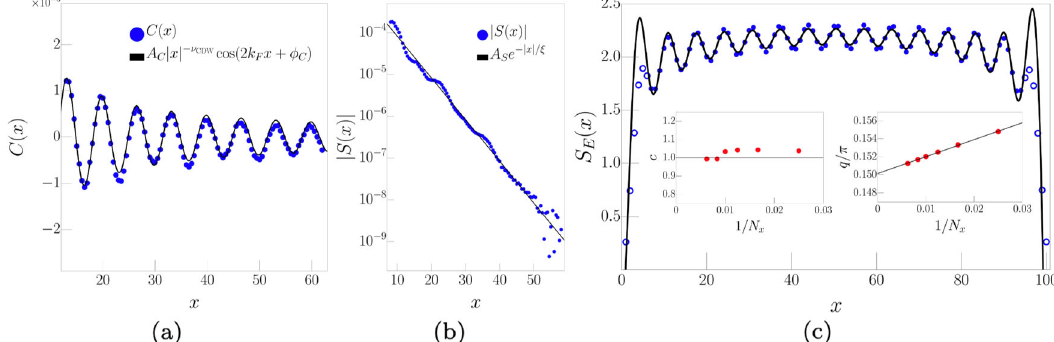
Fig. 4 Evidences for Luther-Emery liquid. a Real-space fi tting A C j x j (cid:2) ν CDW cos ð 2 k F x þ ϕ C Þ of the CDW correlation for a two-leg cylinder with = 240 and n = 0.15 yields ν = 0.90. b Real-space fi tting A e − ∣ x ∣ / ξ of SDW correlation for a two-leg cylinder with N N x S CDW yields ξ = 4.36. c Von Neumann entanglement entropy for a two-leg cylinder with N x = 100 and n = 0.15 (truncation error 5 × 10 − 11 ). Discarding data points at the edges (indicated by open markers), the entropy is fi t to Eq. (5). The extracted central charge is c = 1.03. Left inset: extracted central charge across a range of lengths with n = 0.15 agrees well with c = 1. Right inset: linear extrapolation of the fi tted q in the thermodynamic limit yields q = 0.150 π matching k F = n π = 0.15 π